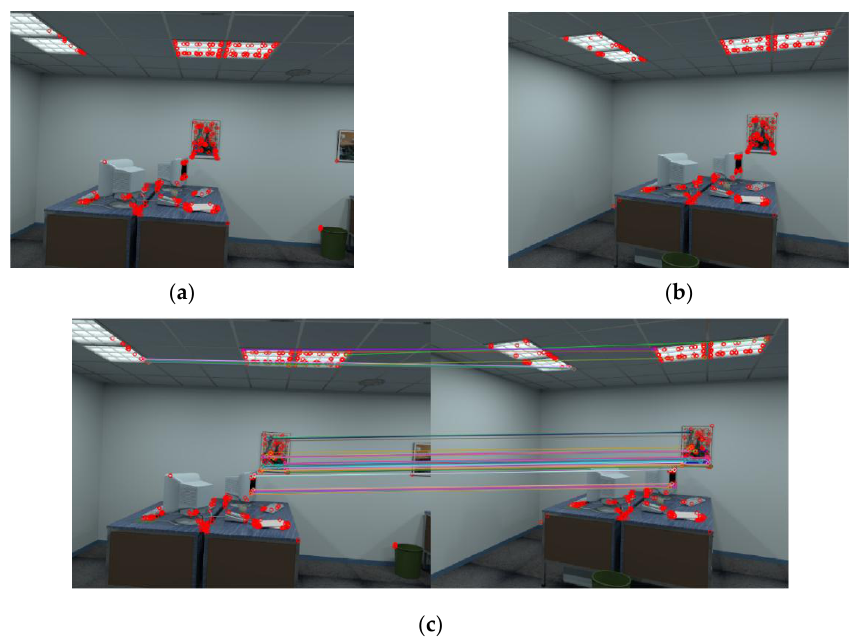
Figure 5. Results of feature detection and matching. ( a , b ) show key-points detected in a pair of images; and ( c ) shows the first 50 matches.